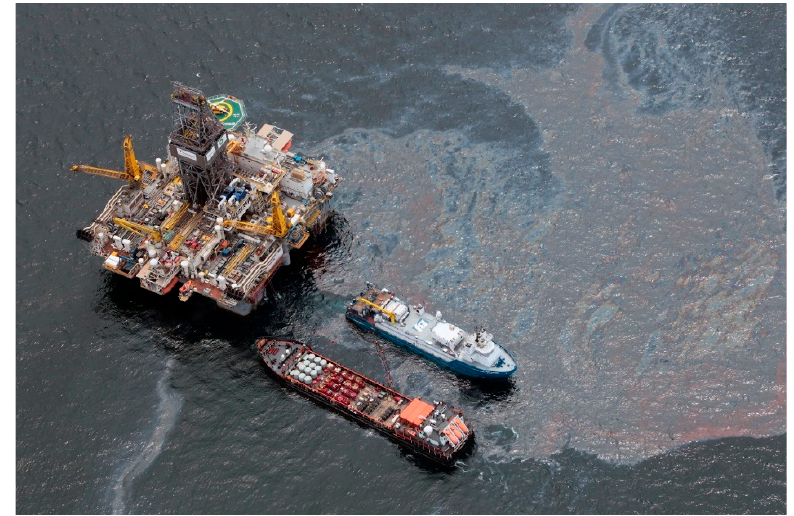
Figure 4. Example of an oil spill image obtained from a UAV [50].